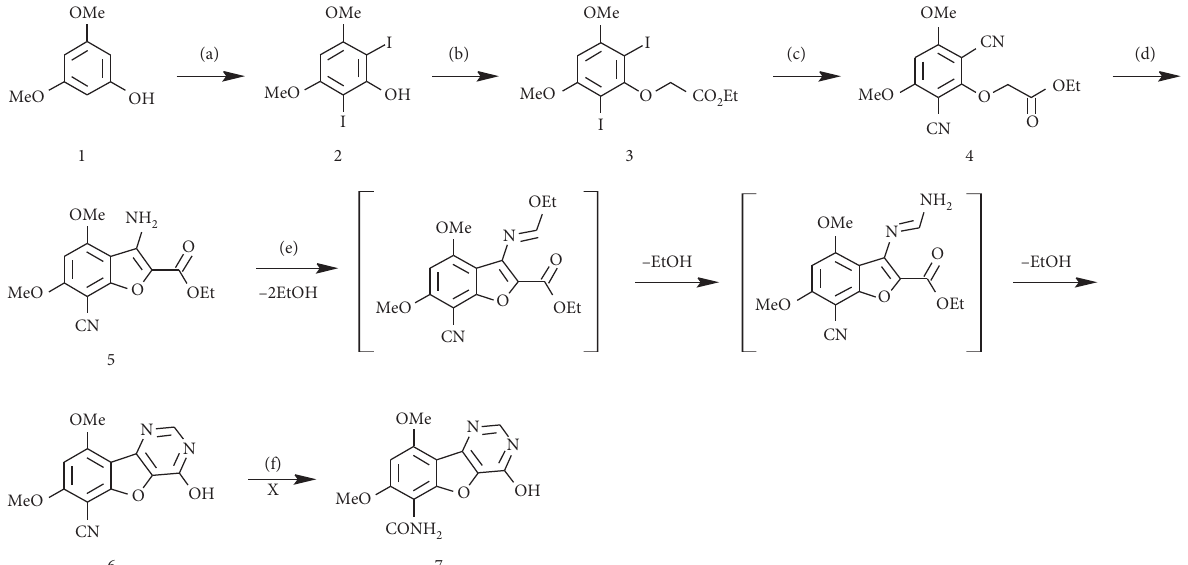
Figure 2: (a) NIS, CH − 78 ° C, 2min, 71%. (b) NaH 60%, DMF, ethyl bromoacetate, rt, 12h, 72%. (c) CuCN, DMF, 160 ° C, 2h, 75%. (d) NaH 2 Cl 2 , 60%, DMF, 0 ° C, 30min, 51%. (e) (1) HC (OEt) 3 , MW, 200 ° C, 15min, (2) NH 3 /MeOH 7N, MW, 140 ° C, 15min, 46%. (f) H 2 O 2 35%, K 2 CO 3 , rt, 24h or NaOH/EtOH 6N, H 2 O 2 35%, rt, 24h or urea-hydrogen peroxide, K 2 CO 3 , acetone/H 2 O, rt, 5h or BF 3 .2CH 3 COOH or H 2 SO 4 cc, 15min,